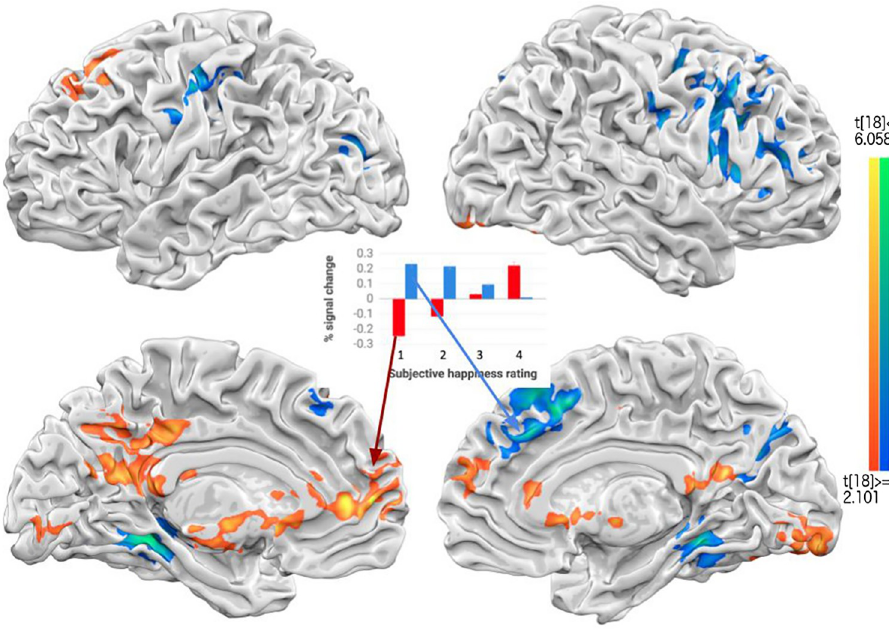
Fig 4. The results of parametric modulation. Medial prefrontal cortex (MPFC), pregenual anterior cingulate cortex (pACC), nucleus accumbens (NAcc), posterior cingulate cortex (PCC), precuneus (Prec), superior temporal gyrus (STG), inferior parietal lobule/TPJ, and insula were positively correlated with subjective happiness ratings, whereas medial frontal gyrus, inferior frontal gyrus, and fusiform gyrus were negatively correlated with the ratings. The central bar graph illustrates two positively and negatively response-correlated brain regions, with their mean percent signal changes (PSC) on each response condition.